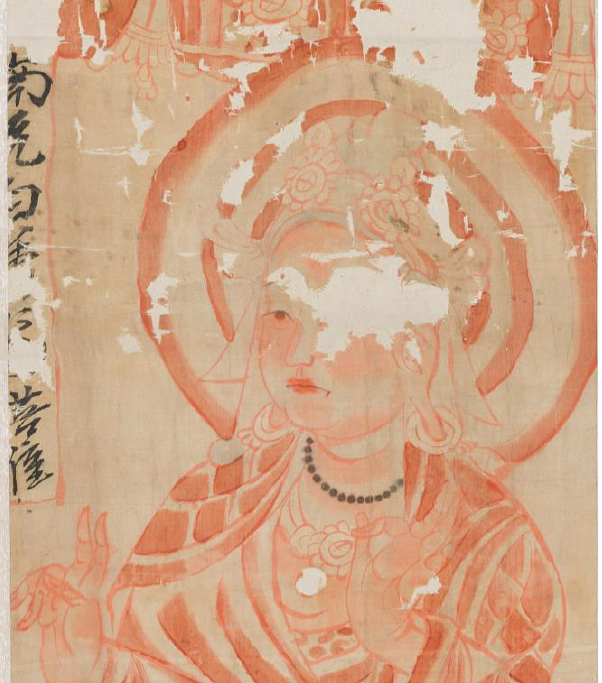
Figure 11. Details of Figure 4, showing the inscription with missing letters, possibly Bodhisattva of White Fragrant Elephant (?). Photograph licensed under Creative Commons, reproduced with permission from National Museum of Korea, Seoul.